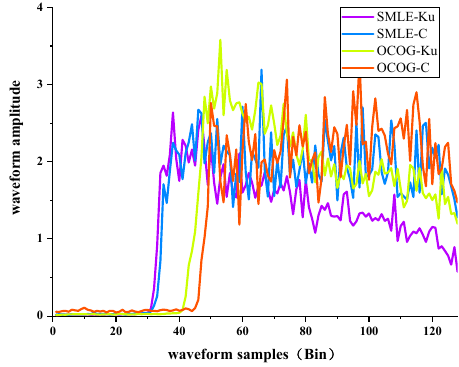
Figure 6. Original and normalized waveforms of the Suboptimal Maximum Likelihood Estimation (SMLE) and Offset Center of Gravity (OCOG) of the diffuse surfaces.